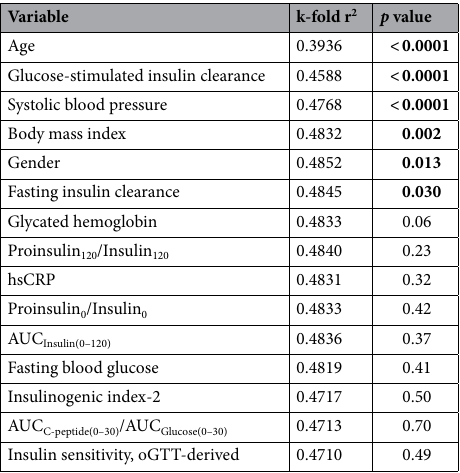
Table 3. Stepwise forward linear regression analysis with fivefold cross validation of variables possibly influencing carotid intima-media thickness with carotid intima-media thickness as the dependent variable. A p -value < 0.05 was considered statistically significant and is given with bold values.